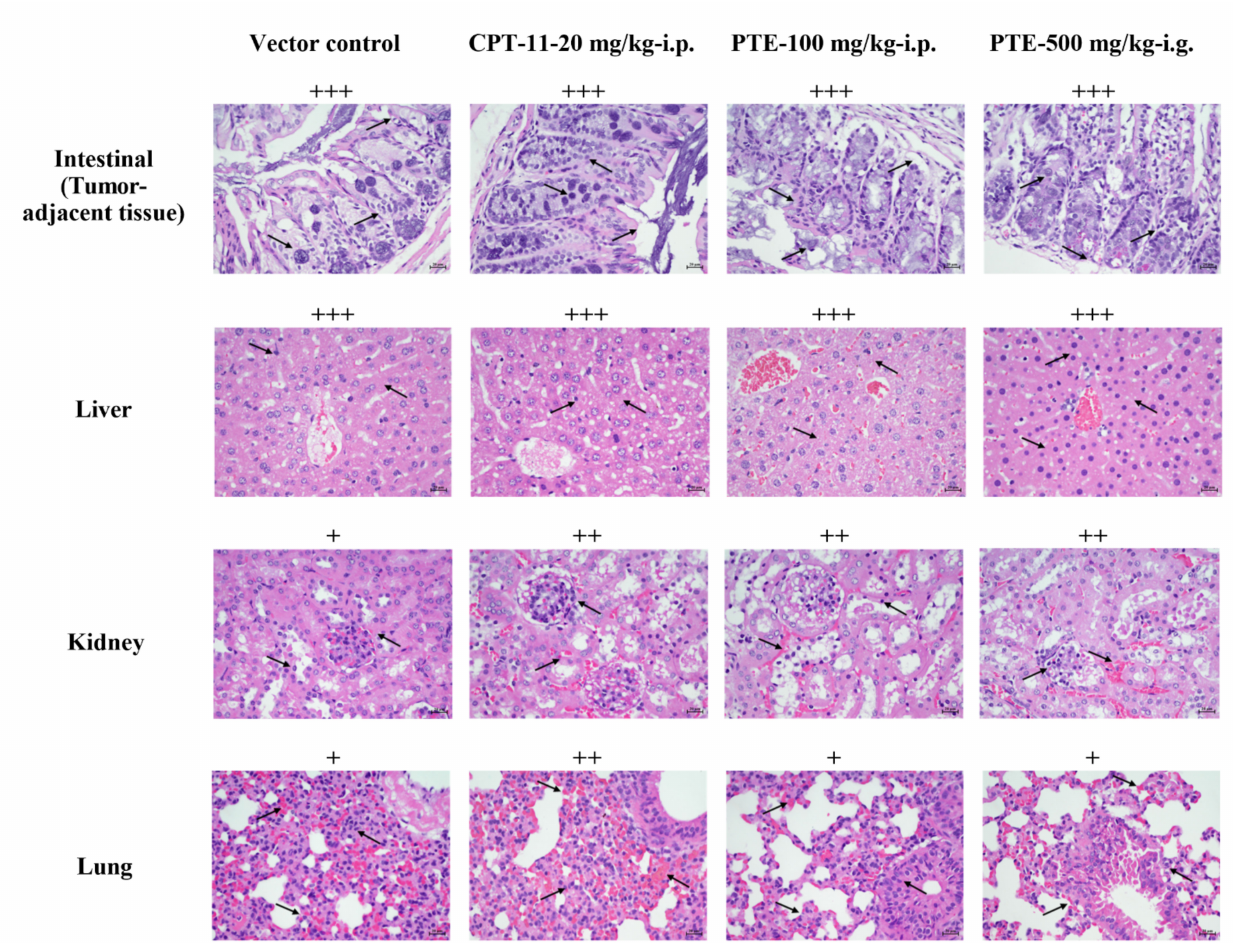
Figure 10. HE assays of paracancerous colon tissues, liver, kidney and lung. The scale bar represents 20 µ m. The degree of organ injury is expressed by +. In intestinal tissue, four indexes are mainly evaluated including gland atrophied, epithelial thinning, goblet cell loss or abscission, and gland loss. Each occurrence of one of them results in an additional +. In the liver, + indicates <5% hepatocyte adipose change, no inflammatory cell infiltration, hepatocyte necrosis, and hepatocyte balloon-like change. ++ means hepatocyte fat change between 5% and 33%, scattered inflammatory cell infiltration, local hepatocyte necrosis, and rare hepatocyte balloon-like change. +++ indicates that hepatocyte fat change between 34% and 66%, focal inflammatory cell infiltration, local or diffuse hepatocyte necrosis, and hepatocyte balloon-like change was less than 5. ++++ indicates >66% fatty changes in liver cells, severe inflammatory cell infiltration, necrosis area of liver cells >1/2 of hepatic lobular area, and >5 hepatocyte balloon-like changes in liver cells. In the kidney, four indexes are mainly evaluated including glomerular size change, glomerular cell degeneration or necrosis, kidney tubules swelling and congestion, and inflammatory cell infiltration. Each occurrence leads to an additional +. In the lung four indexes are evaluated: alveolar wall thickening, alveolar congestion, alveolar structural destruction (bullae), and inflammatory cell infiltration. Each occurrence of one of them results in an additional +. Typical lesions in each organ are indicated by black